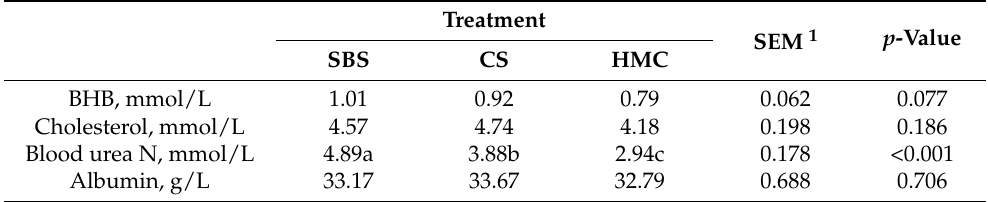
Table 5. Blood parameters of grazing dairy cows supplemented with PMR composited by sugar beet silage, corn silage, or HMC.